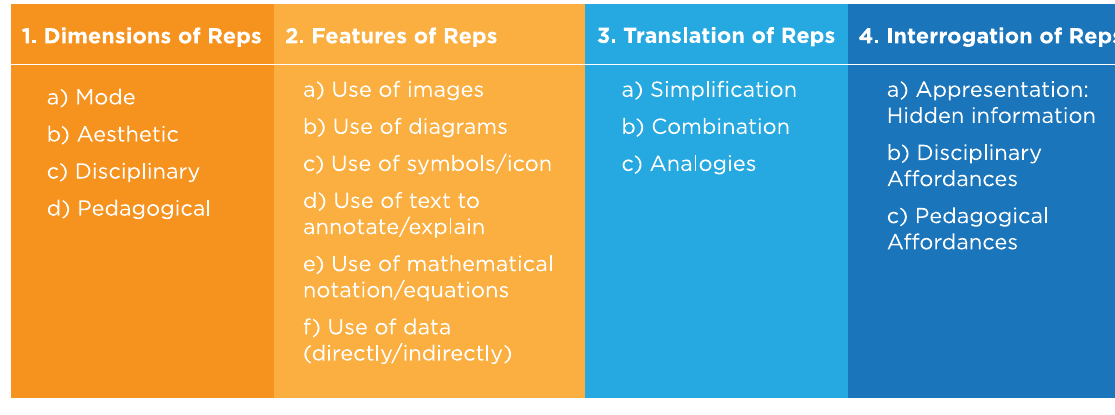
FIG. 11. Characteristics of representations ( “ Reps ”